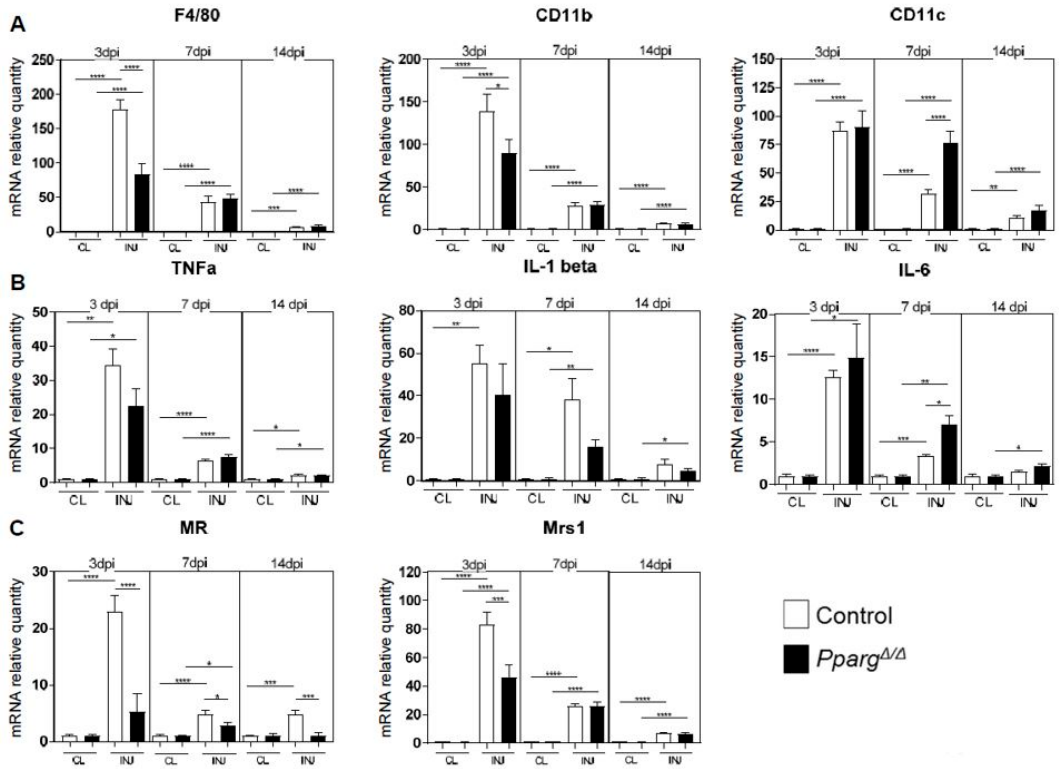
Figure 6. The inflammatory response during muscle regeneration is altered in Pparg Δ / Δ mice. mRNA quantification by qPCR of immune cell marker in injured (INJ) and non-injured contra-lateral (CL) muscles at 3, 7 and 14 dpi. Results are normalized to the non-injured CL muscles. ( A ) Cellular surface macrophages markers: F4/80 = EMR1 (EGF-like module-containing mucin-like hormone receptor-like 1), CD11b = Integrin alpha M, CD11c = Integrin alpha X. ( B ) Cytokines: TNF α = Tumor necrosis factor alpha, IL-1 β = Interleukin 1 beta, IL-6 = Interleukin 6. ( C ) Anti-inflammatory cellular macrophages markers: MR = mannose receptor, Msr1 = Macrophage scavenger receptor 1. n ≥ 7 mice. **** p < 0.0001, *** p < 0.001, ** p < 0.01 * p < 0.05 by one-way analysis of variance (ANOVA). Unless otherwise indicated, statistical comparisons relate to the CL condition of the same genotype.